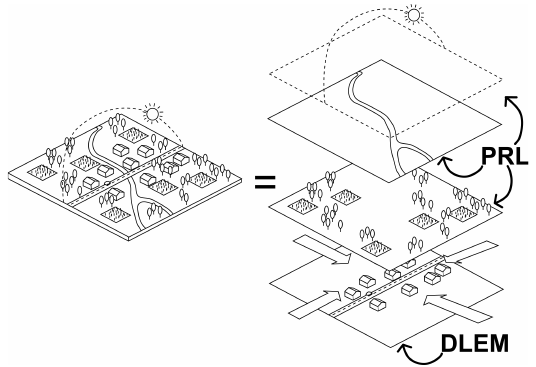
Figure 1. Data on local renewable potential (PRL) and local energy and matter demand (DLEM) can be managed in the same GIS project